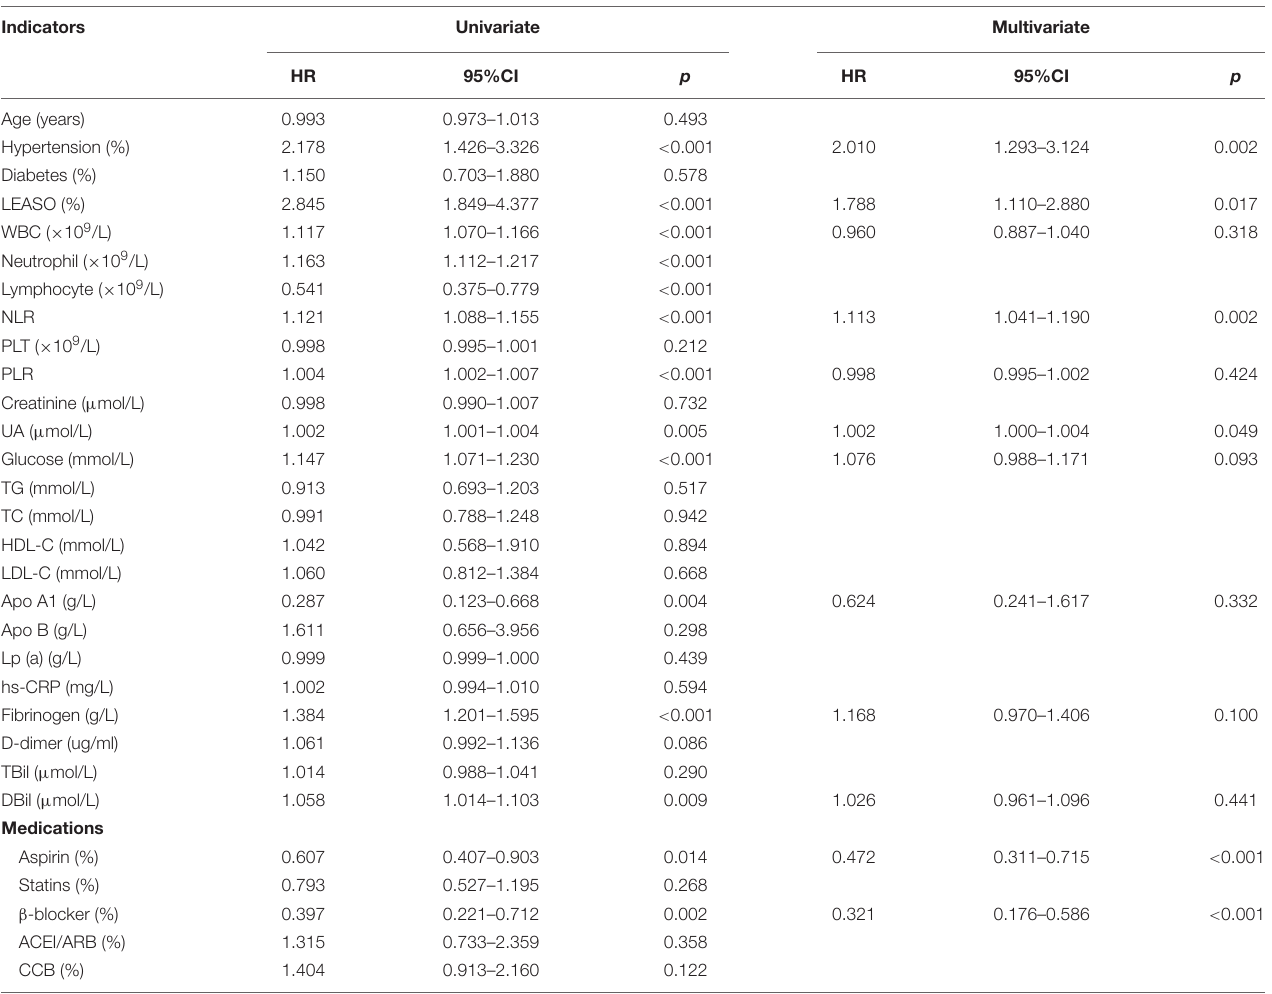
TABLE 5 | Predictors of the occurrence of MACCEs in female patients: results of univariate and multivariate Cox-regression analyses. Indicators Univariate